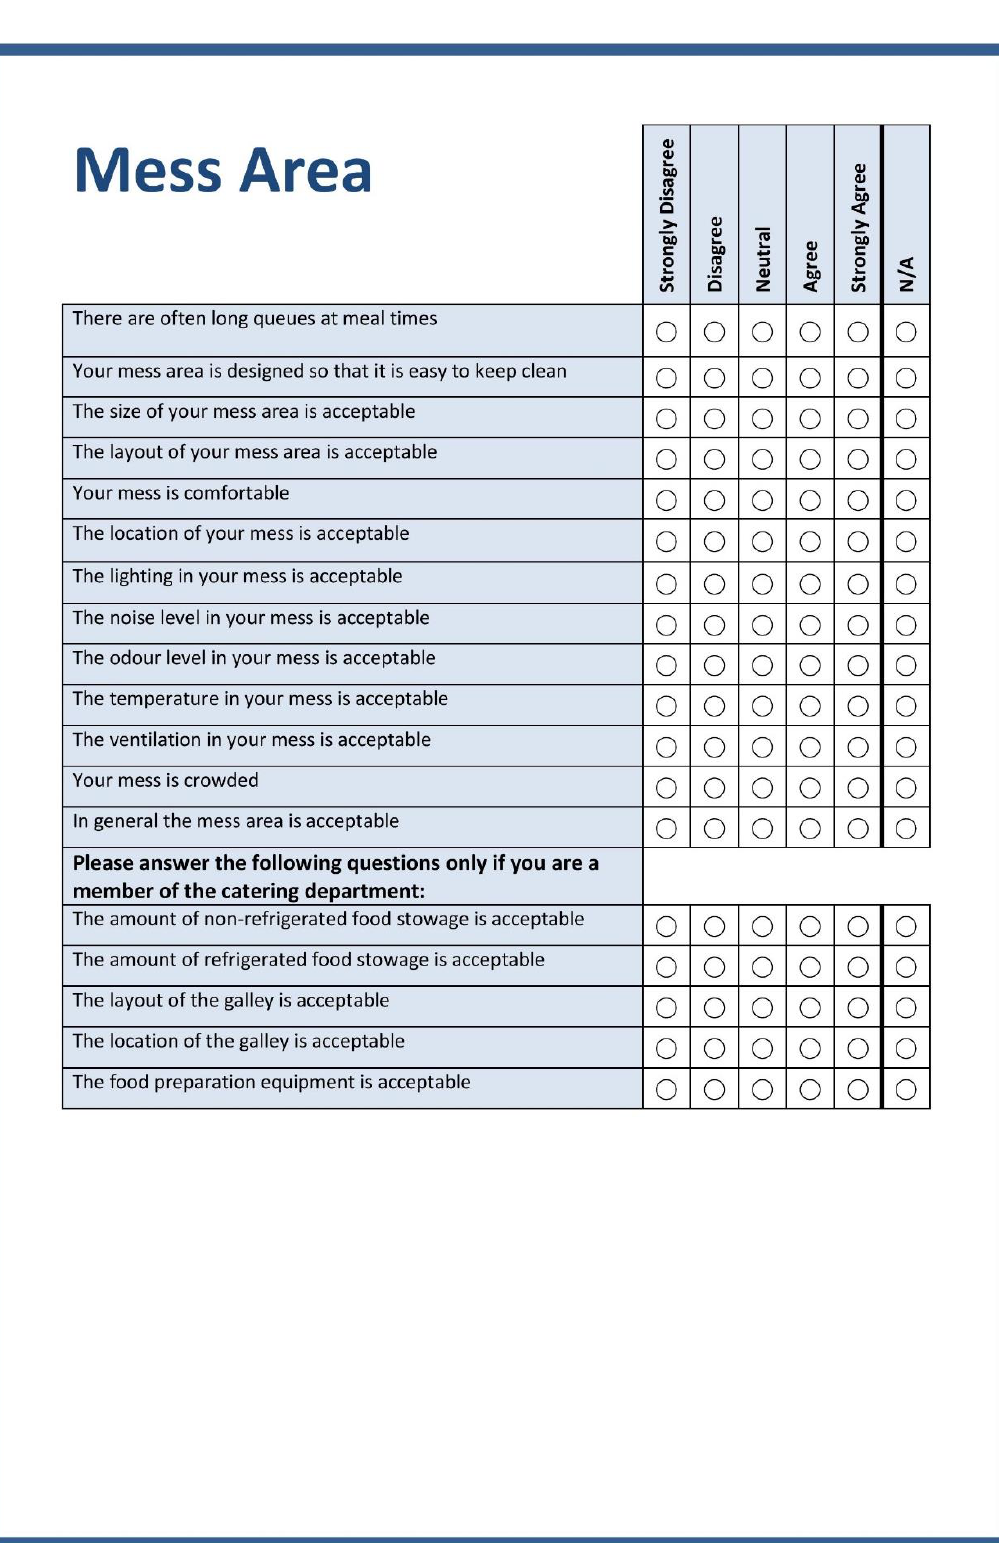
Figure A6. The Submarine Habitability Assessment Questionnaire (continued).